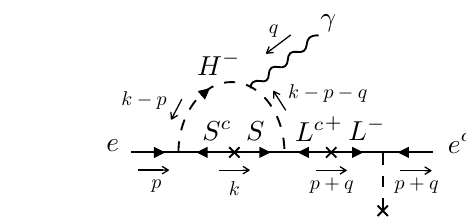
= 0 . Both diagrams are V Y Y L R V